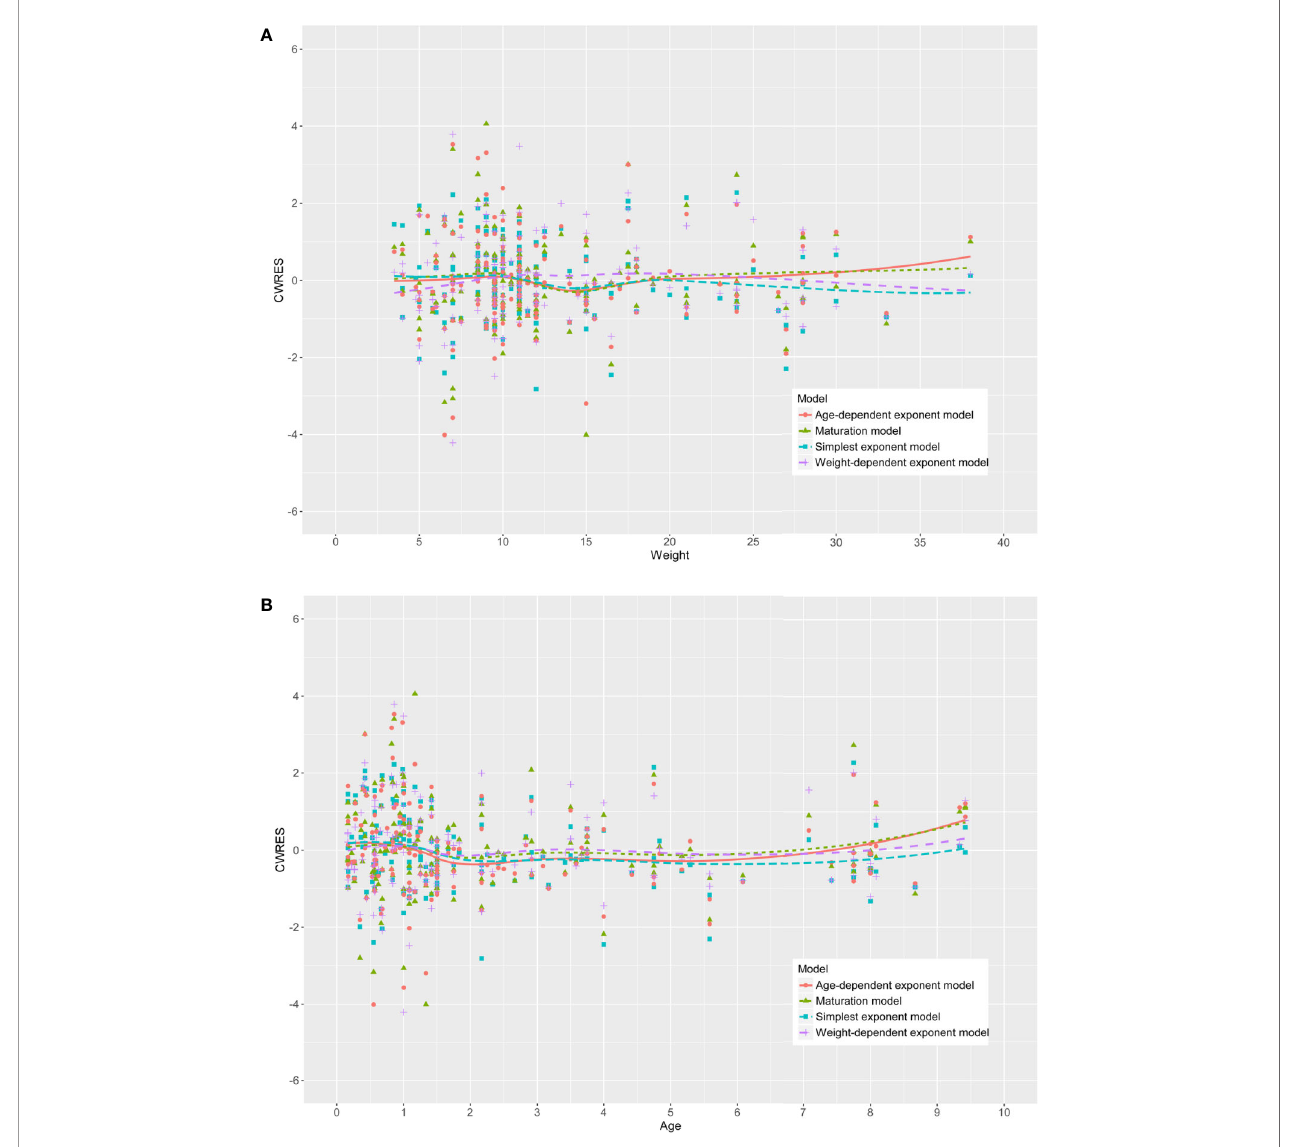
FIGURE 2 | The conditional weighted residuals (CWRESs) with (A) weight or (B) age of the four development models. TABLE 3 | Final model development process and statistical